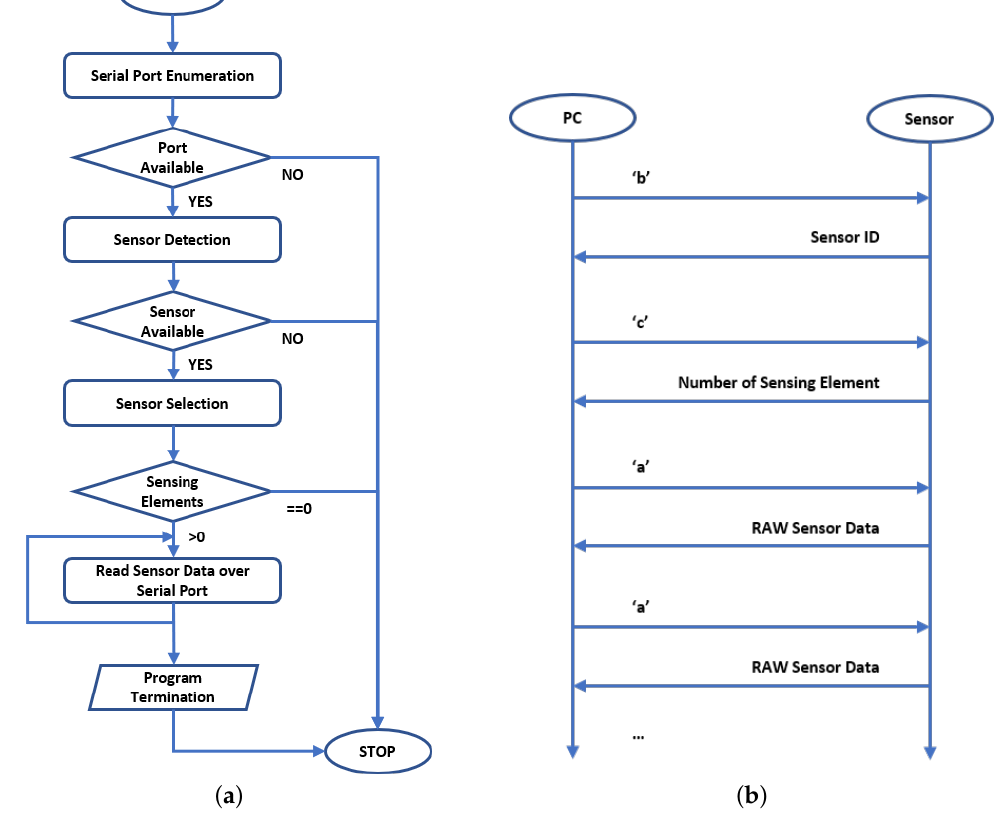
Figure 6. Elaboration system software design: software flow chart ( a ) and protocol sequence dia- gram ( b